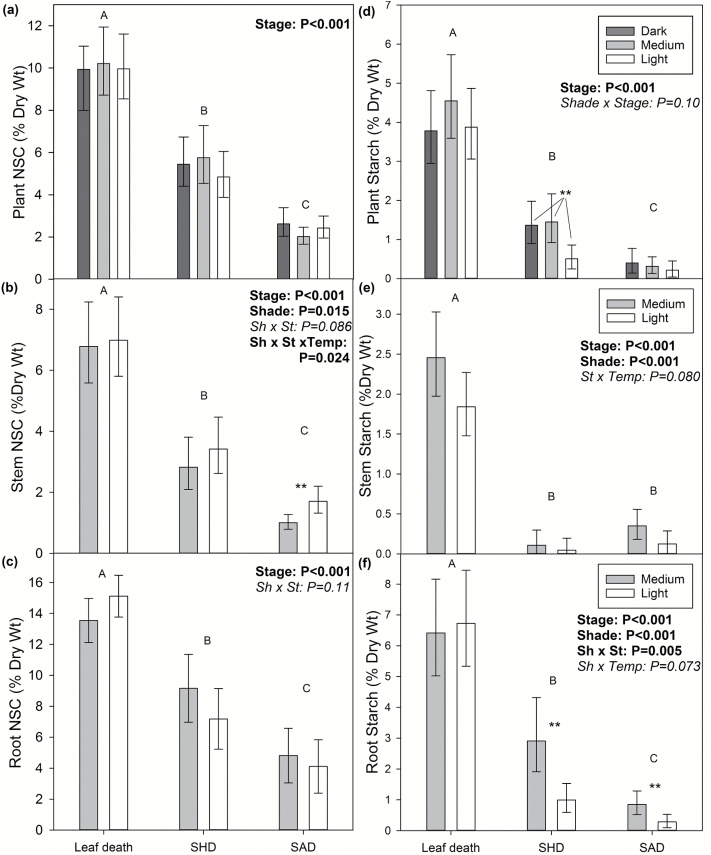
Plant, stem, and root non-structural carbohydrate (NSC) concentrations throughout starvation. (a) Total NSC and (d) starch concentrations for whole plants (i.e. roots + stem) for dark-, medium-, and light-shade treatments at the following stages of starvation: during leaf death (n=19, 20, 21), at stem half dead (SHD; n=11, 9, 10), and at stem all dead (SAD; n=8, 13, 11). (b, c) Total NSC and (e, f) starch concentrations for stems and roots separately for medium- and light-shade seedlings during leaf death (n=19,21), at SHD (n=8,10), and at SAD (n=13,13). Only significant ANOVA effects are listed. Different letters represent significant differences between stages of starvation across darkness-treatment temperatures and initial shade treatments. Asterisks indicate significant shade treatment effects at each stage (*P<0.05, **P<0.01, ***P<0.001). Values are marginal means calculated across both temperatures (all back-transformed except for root NSC), and error bars represent 95% CI. Temperature effects are not shown separately because main temperature effects were not significant.